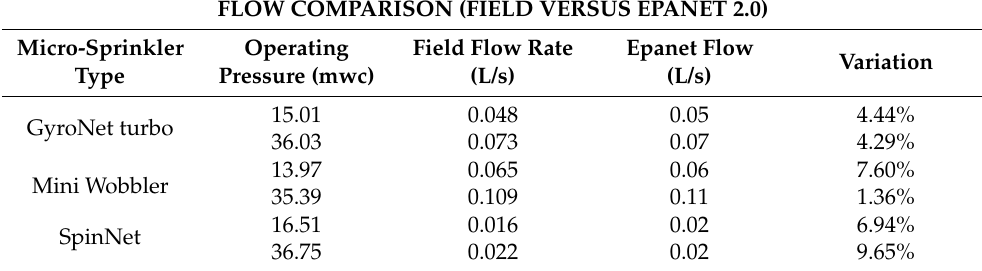
Table 3. Comparison of field measured and modelled discharge flow rates in Epanet 2.0 micro- sprinklers.